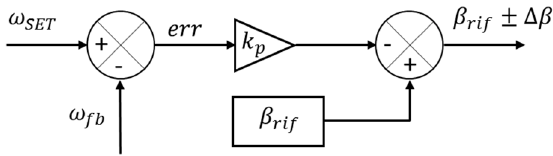
Figure 8. Pitch controller. Figure 8. Pitch